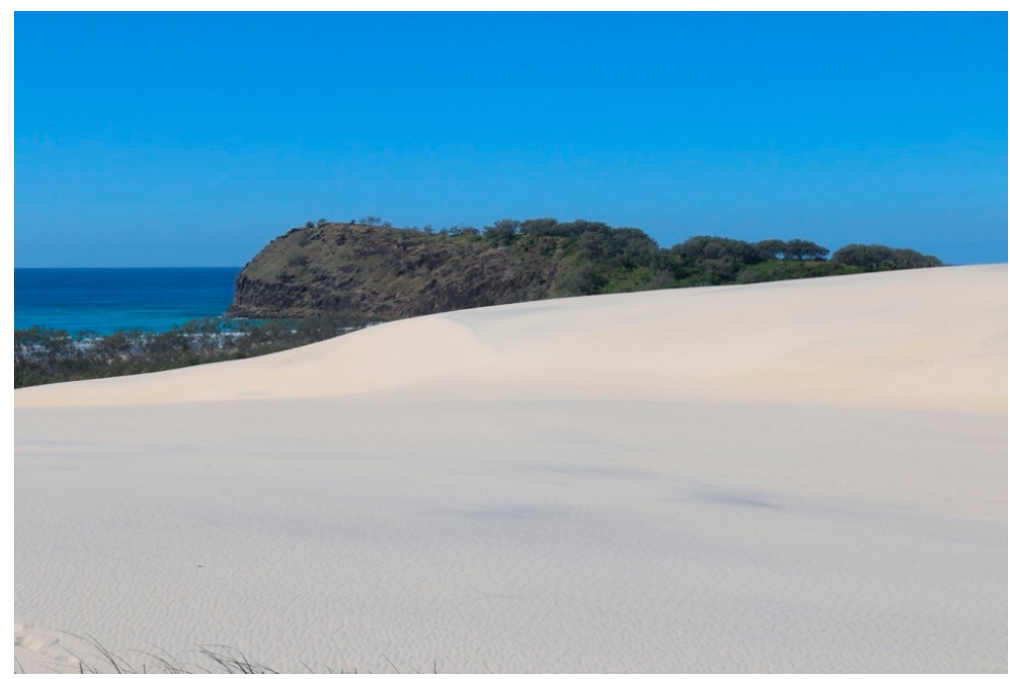
Figure 13. One of the sand dunes on K’gari (Fraser Island) overlooking Takky Wooroo (Indian Head). Photograph by Fiona Foley.